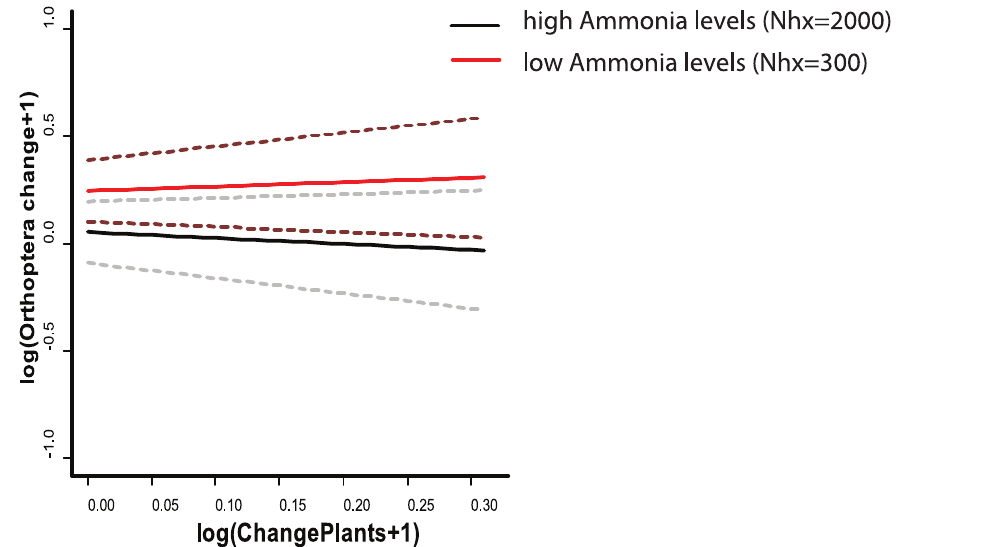
Figure 3. Orthoptera species richness change ( + 2 SD, dashed lines) against plant species change at low versus high nitrogen levels (all Orthoptera). All comparisons between the second (1976–1990) and third time period (1996–2010) and in 10 km grid cells. The black lines show the estimated values for Orthoptera under a fixed value of ammonia; the grey lines represent the 95% confidence intervals. Ammonia levels in mol/ ha.